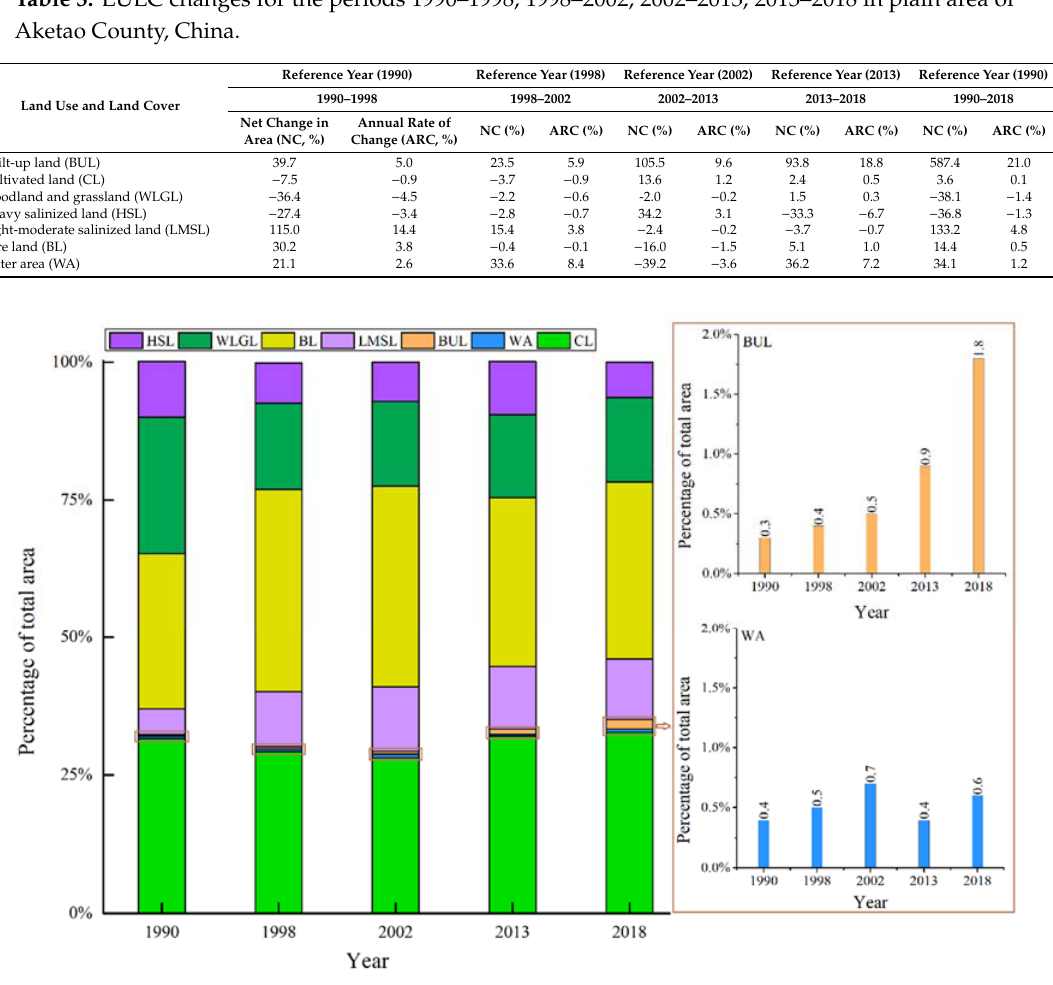
Figure 2. Trend in LULC change in the arid piedmont plain, Aketao County, China (1990–2018).